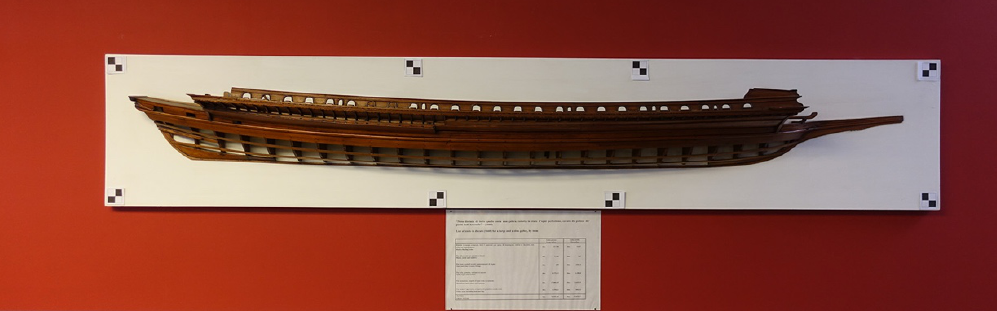
Figure 1. The half model of the galea